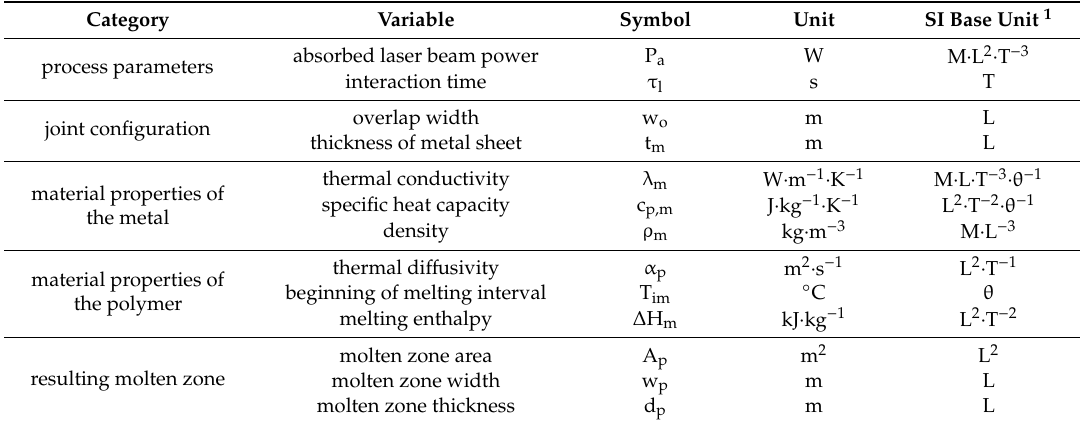
Table 2. Relevant parameters for dimensionless